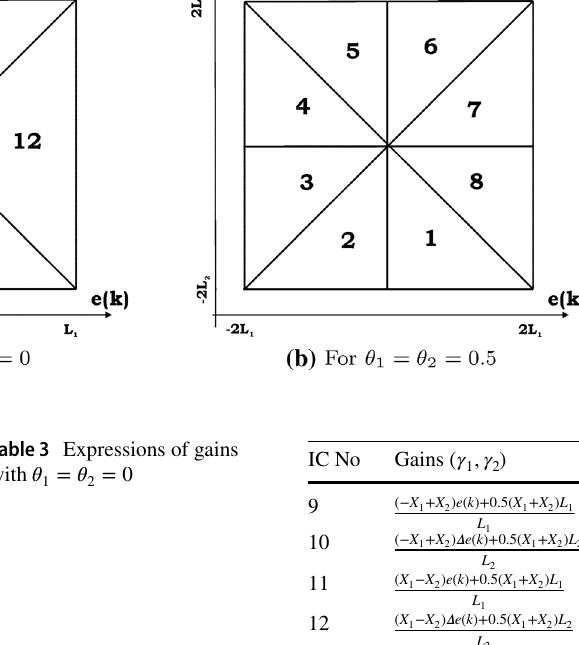
Fig. 7 Input combinations with varying FoUs